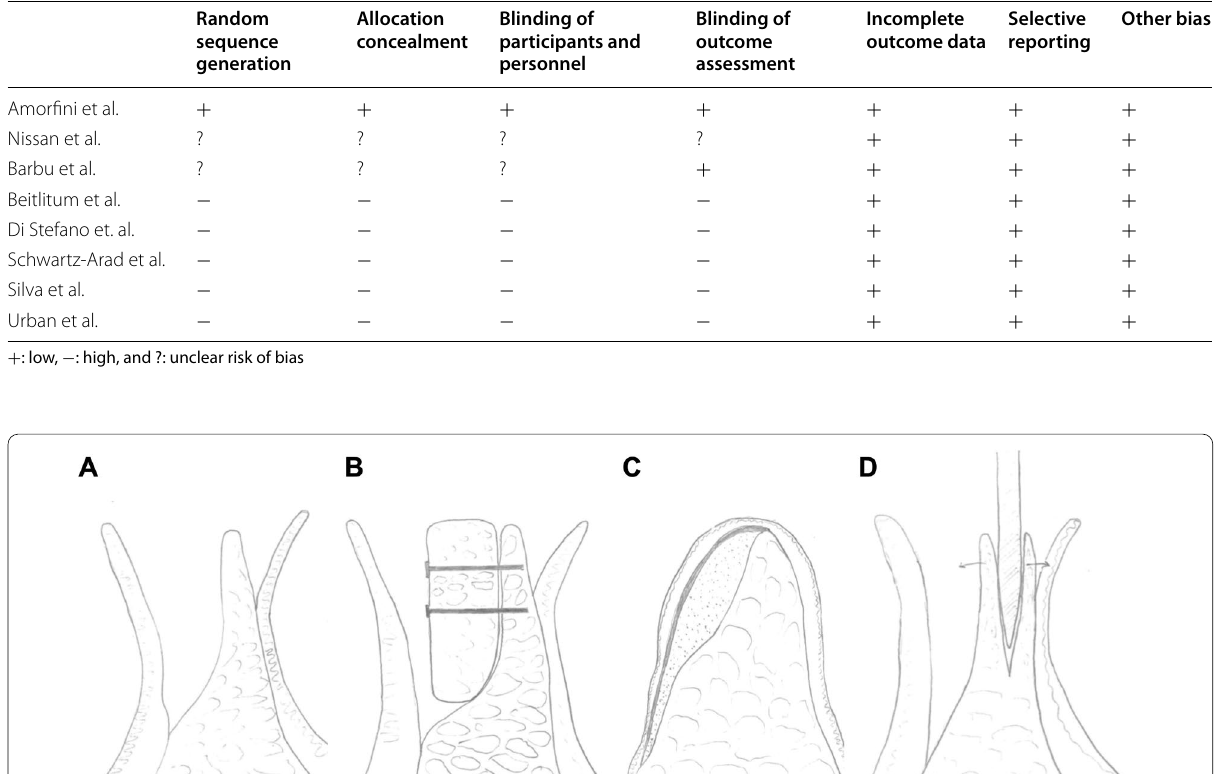
Table 2 Assessment of risk of bias according to The Cochrane Collaboration’s tool for RCTs, the ROBINS‑I tool was applied for prospective cohorts, and the Checklist for Case Series from the Joanna Briggs Institute